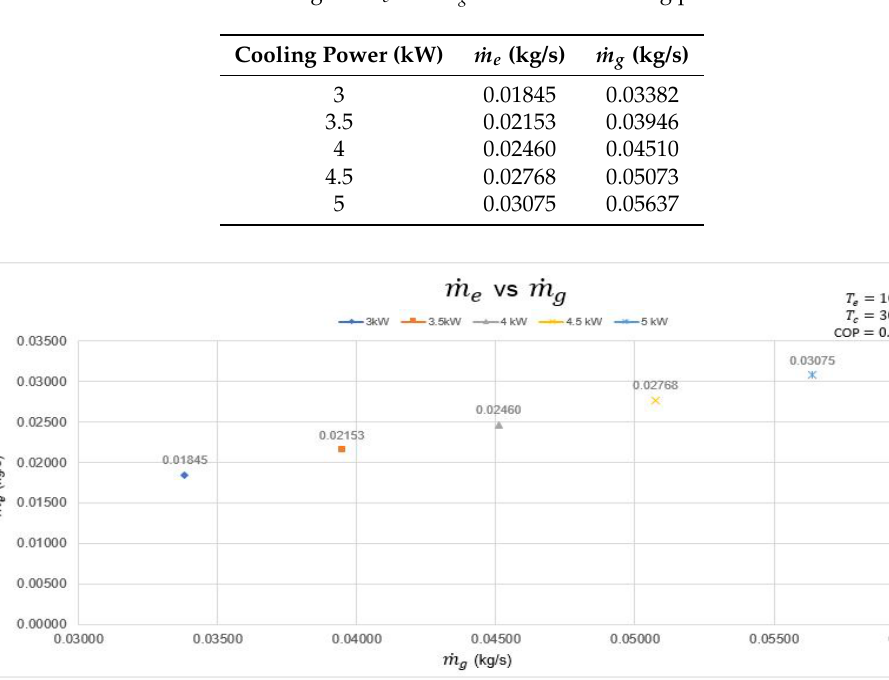
Table 3. Average of ˙ m e and ˙ m g for different cooling powers.